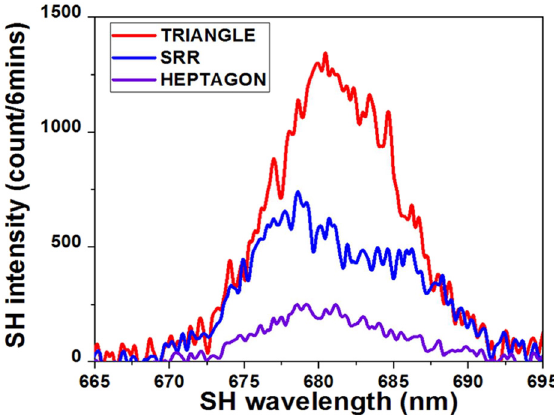
Figure 7: Comparison of transmitted second harmonic spectra for SRR, heptagonal and triangular Au-DRMs under the same experi- mental condition. The incident polarization is y -polarization at fundamental resonant wavelength of 1360 nm and SHG emission was detected for x